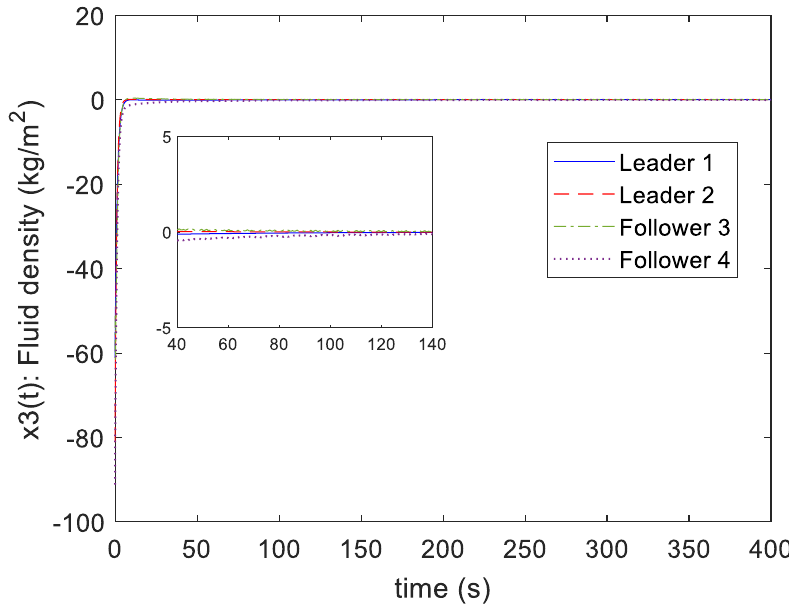
Figure 7. Responses of state x 3 ( t ) with IT-2 fuzzy control.